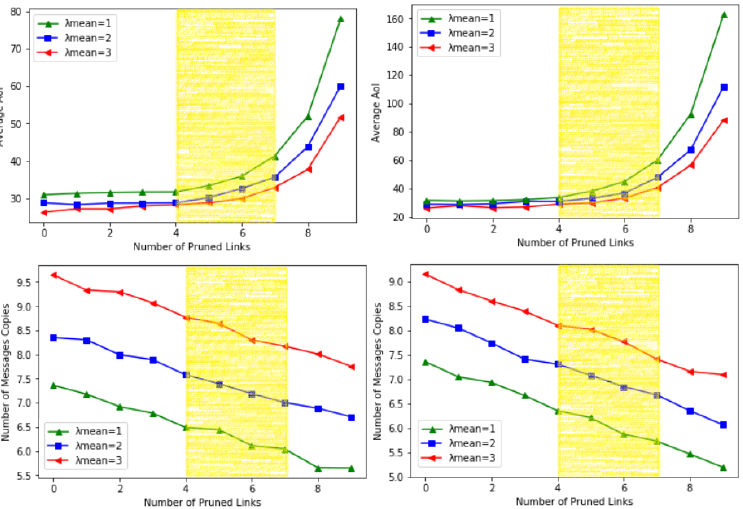
Figure 12. The simulation results from running the pruning algorithm on the low-clustered topology when µ = 1. The left column is the result after running the algorithm when σ = 1 and the right column is the result after running the algorithm when σ = 2.